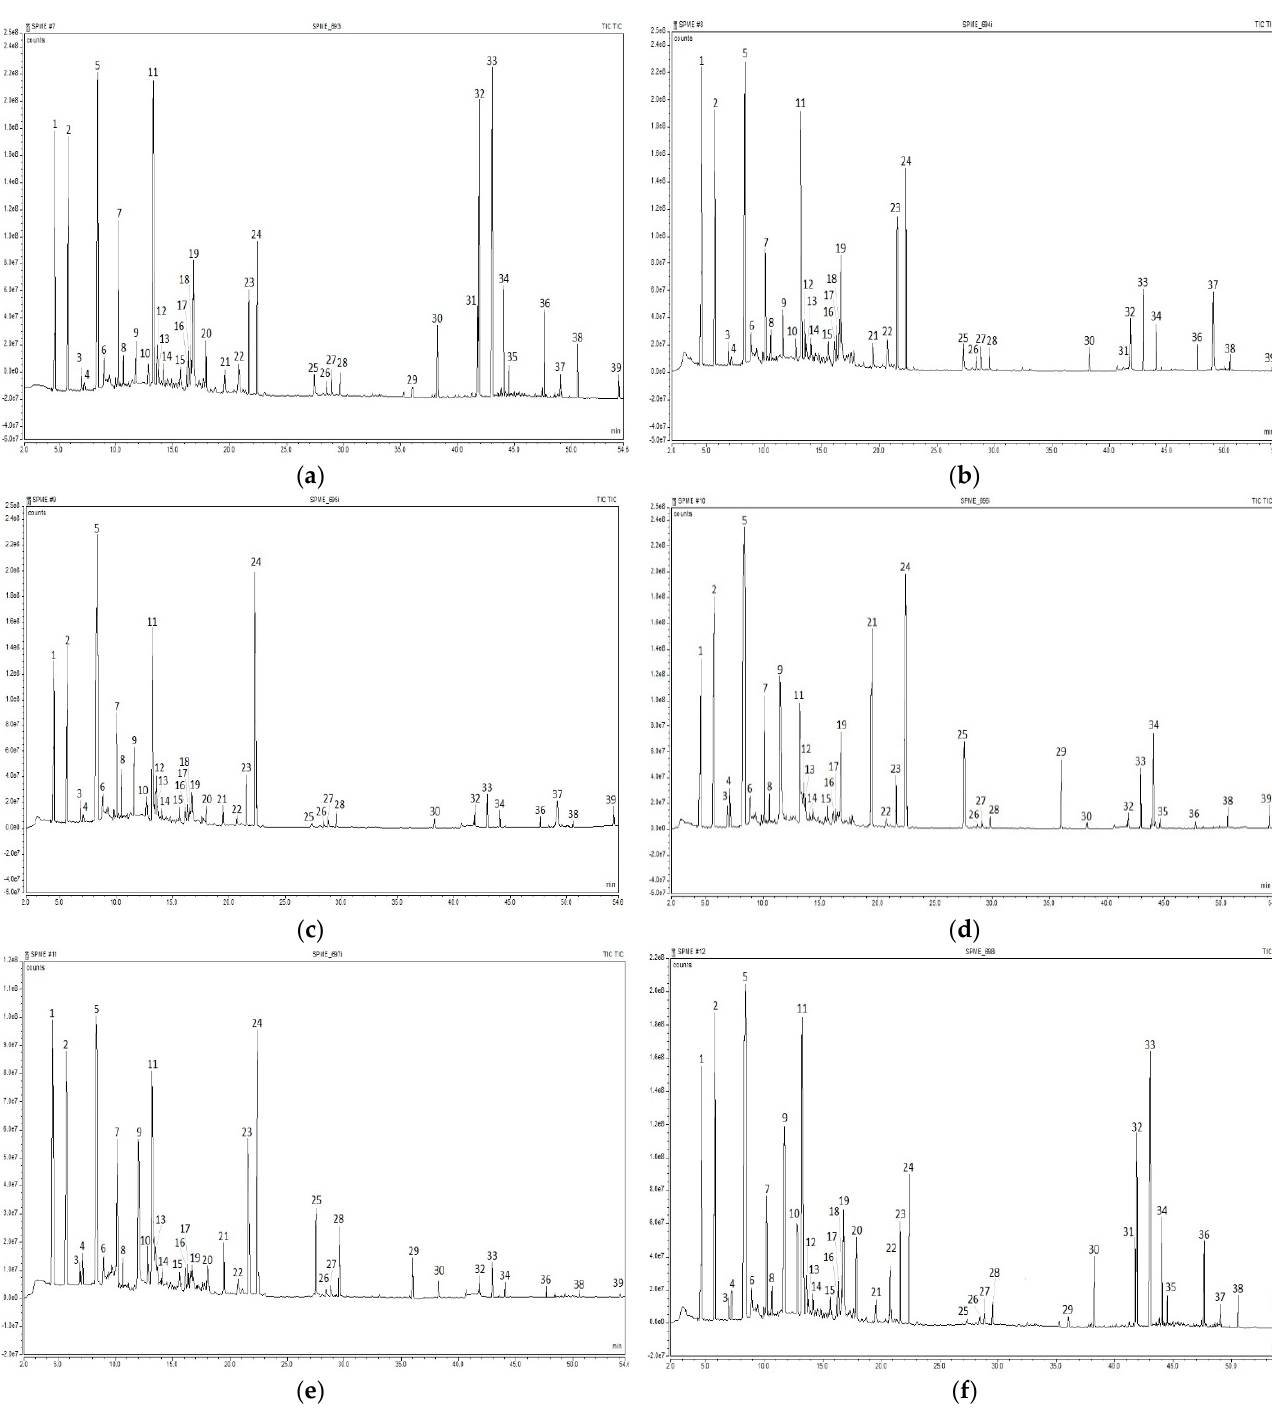
Figure 3. Total ion chromatograms of volatile organic compounds identified in coffee samples by HS-SPME-GC-MS analysis: ( a ) C1; ( b ) C2; ( c ) C3; ( d ) C4; ( e ) C5; and ( f ) C6.